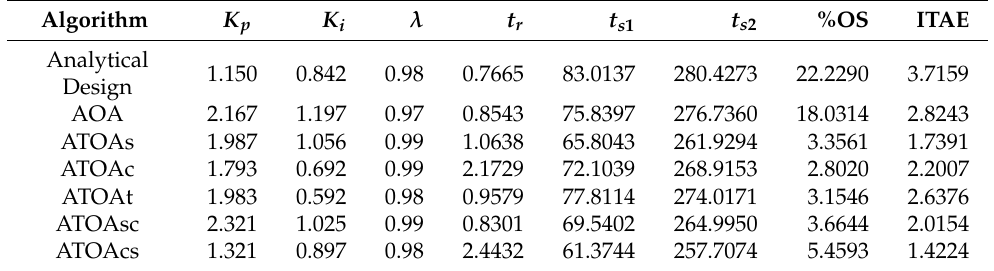
Table 5. Performance comparison of the different algorithms in presence of FOPPI controller.